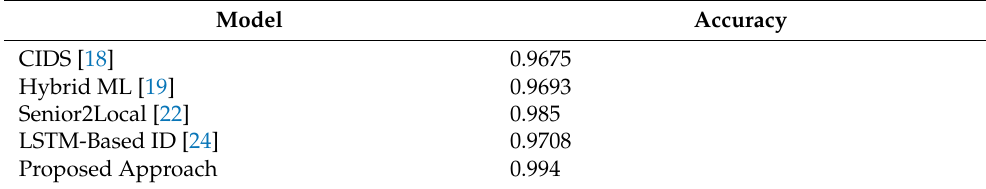
Table 3. Comparison with state-of-art methods.